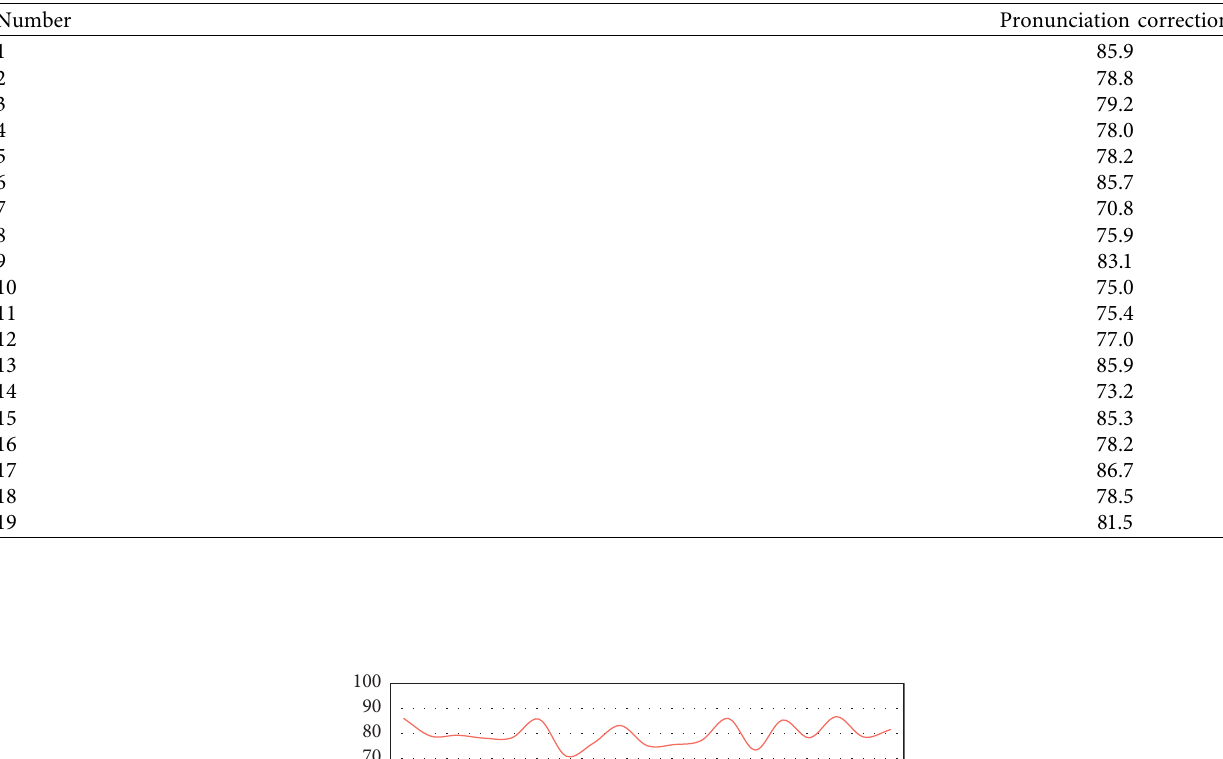
Table 3: Evaluation data of pronunciation correction effect of spoken English reading.